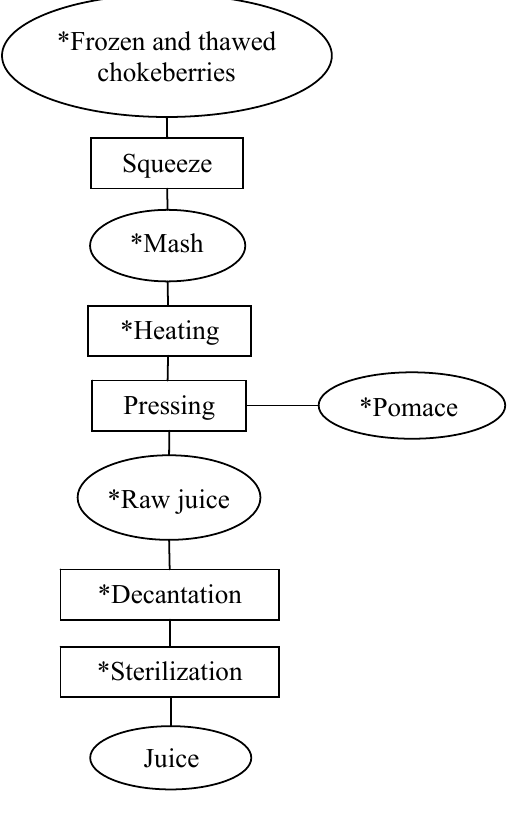
Figure 1. Chokeberry juice processing (sampling points marked by